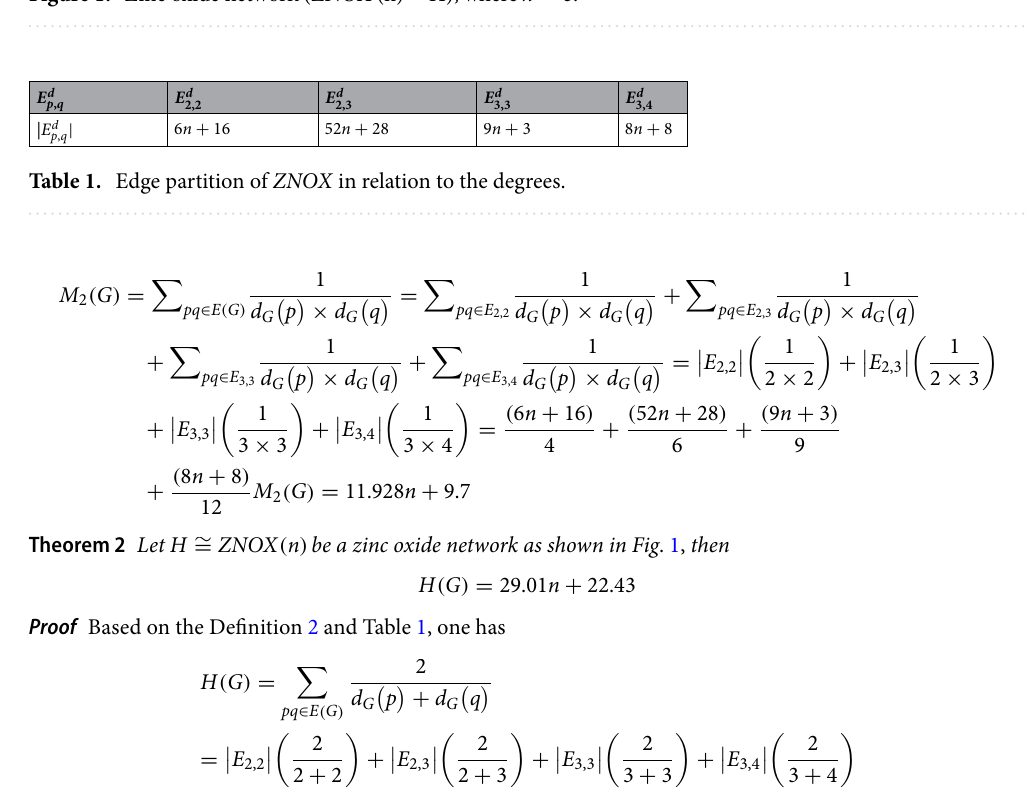
Figure 1. Zinc oxide network (ZNOX (n) ∼= H), where n